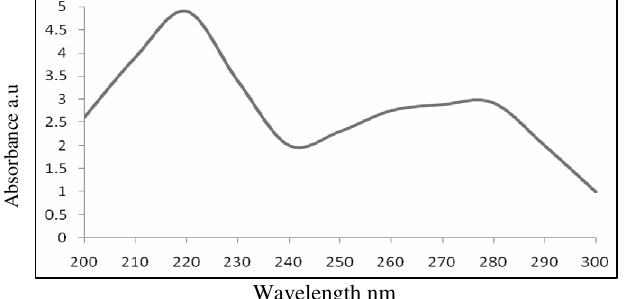
Figure 5. UV-Vis spectra in the low wavelength region recorded from the reaction of 10 -3 M AgNO with culture supernatant of Bacillus subtilis after 12 th cycle of microwave 3